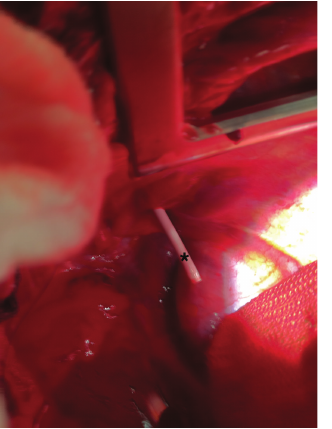
Figure 1: Subclavian central venous catheter (asterisk) in